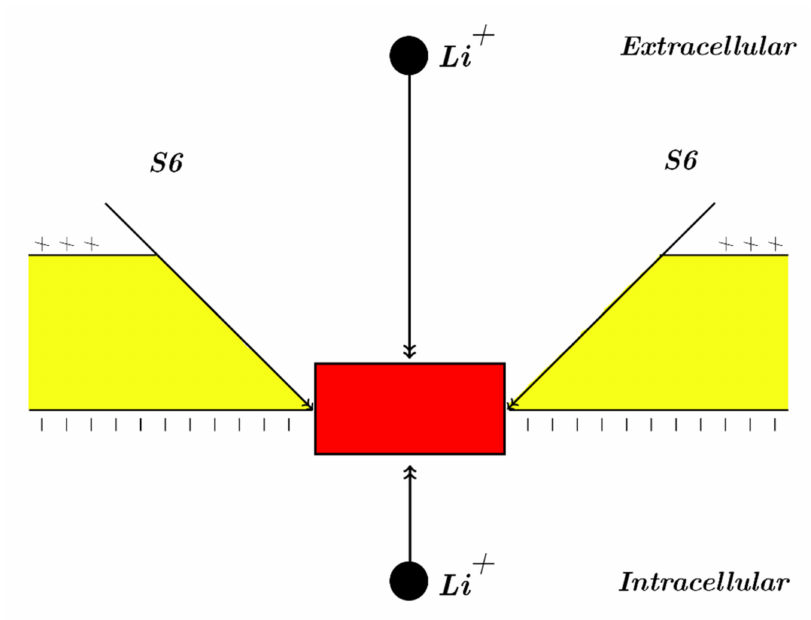
Figure 1. The figure represents a schematic diagram of the closed intracellular gate, which is red in color, made by a constriction of the hydrophobic residues of the S6 alpha helices of the voltage-gated sodium channel. The extracellular lithium ions pass across the membrane voltage until hitting the closed gate, while the intracellular lithium ions hit the closed gate before going through the membrane